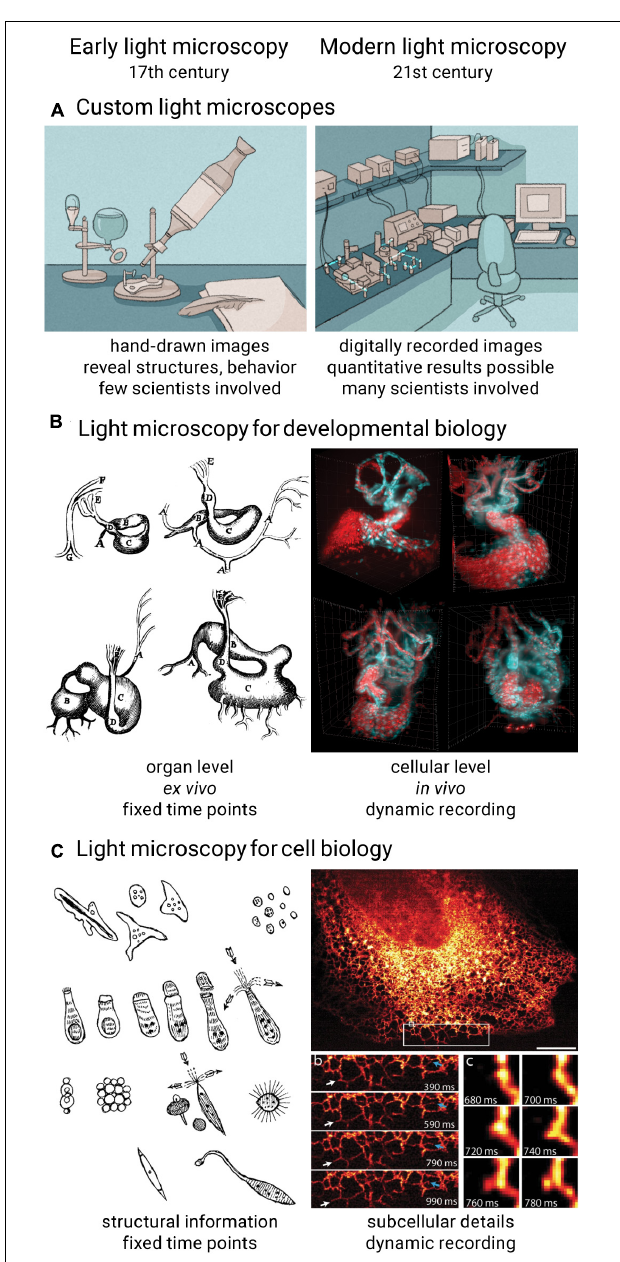
FIGURE 1 | Comparison of early and modern light microscopy. Over the course of 400 years, light microscopes transformed from pure lens arrangements into complex and automated devices (A) . Light microscopy techniques in developmental biology can now capture dynamic processes in tissues, organs and organisms under nearly physiological conditions (B) (West, 2013; Mickoleit et al., 2014). In cell biology, light microscopes are now capable of recording fine subcellular details (C) (York et al., 2013; Rob et al., 2016). Previously published images reused under license